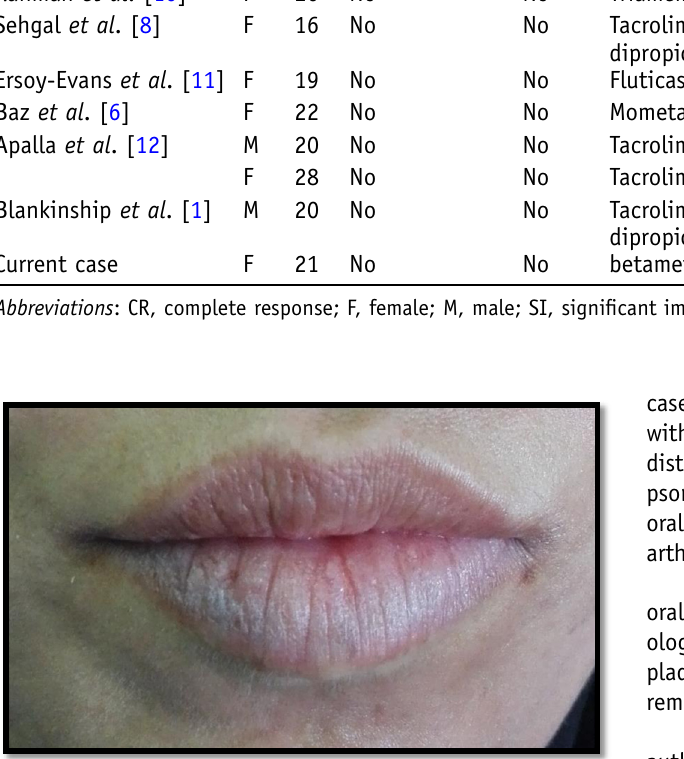
Fig. 3. Appearance of the lips at 15 days of control showing a notable improvement.